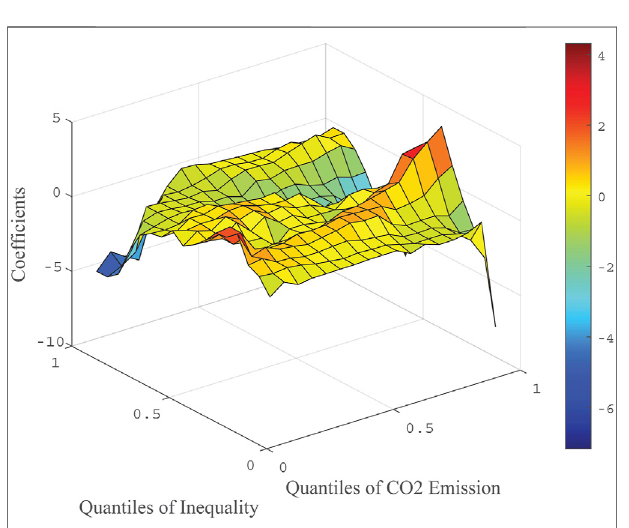
FIGURE5 | The impact ofincome inequality on carbon emissions (U.S.).